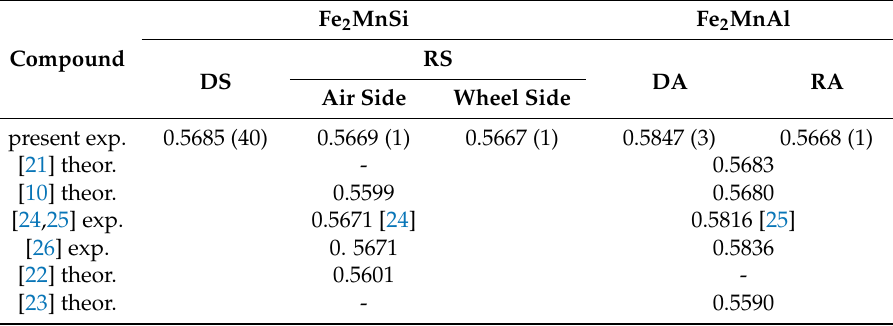
Table 2. Measured lattice parameters, a (nm), for the Fe 2 MnSi (DS, RS) and Fe 2 MnAl (DA, RA) samples; theoretical data (theor.) and experimental data (exp.) for bulk samples of other authors are quoted for comparison.